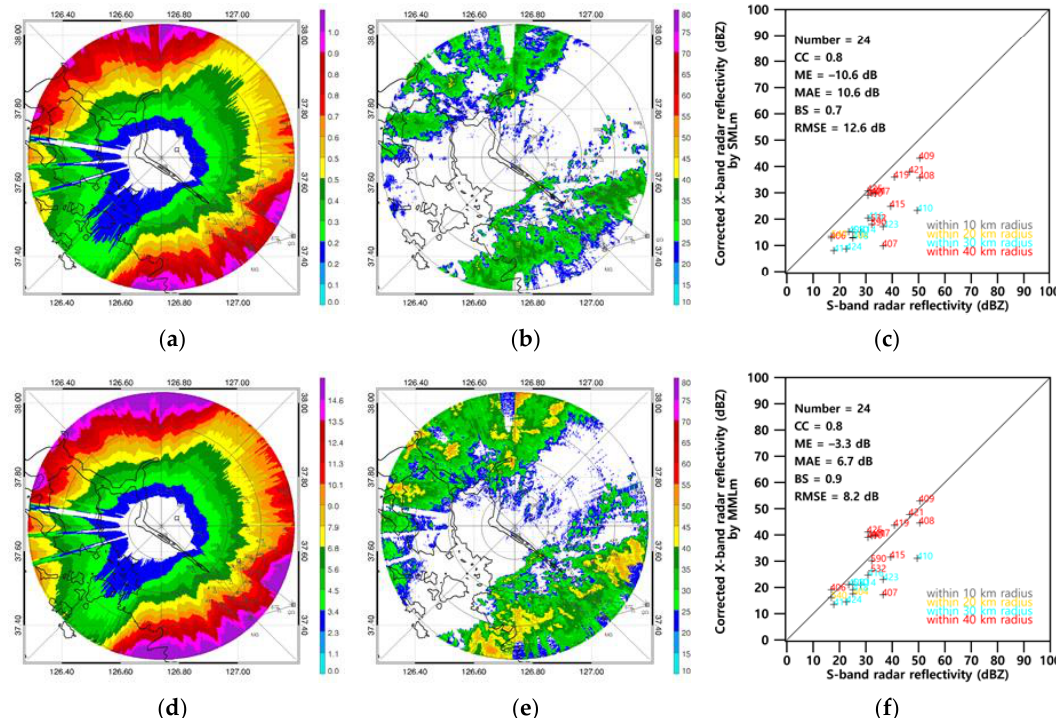
Figure 7. Radar attenuation estimated for the convective case using the two correction methods ( a , d ). Their corrected reflectivity is shown in the middle row ( b , e ), and comparisons between S-band radar reflectivity and corrected X-band radar reflectivity are presented in the right row ( c , f ). The top line represents SMLm, and the bottom line is the MMLm.